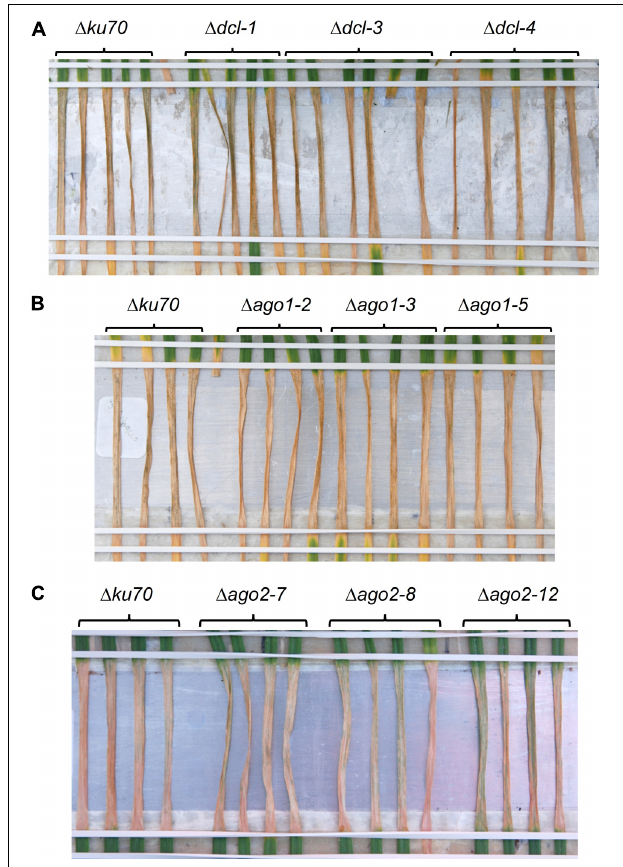
FIGURE 4 | Zymoseptoria tritici infection bioassays. Z. tritici IPO323 strain (cid:49) ku70 and its derivatives deficient in RNA silencing pathway ( (cid:49) dcl , (cid:49) ago1, or (cid:49) ago2 ) were inoculated onto the wheat cv. Bobwhite. Three randomly chosen mutant strains for each target gene were tested by inoculation onto at least 4–5 individual wheat seedlings, and this data is shown in panels (A–C) . Fungal inoculations were done using suspension of conidiospores at 1 × 10 6 mL − 1 and the inoculated leaves were phenotyped and photographed at 16 days